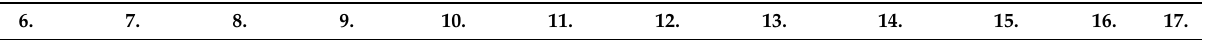
Table 7. Mean Scores per Discipline for Main